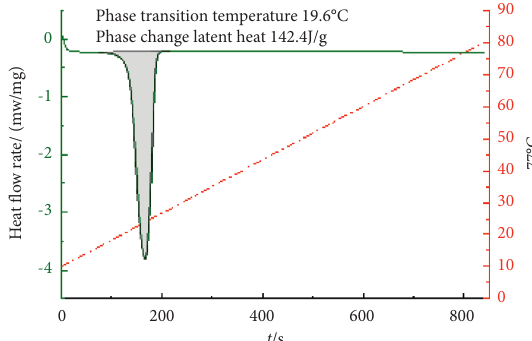
Figure 9: TD-MA :LA is the DSC curve of TD-MA-LA at